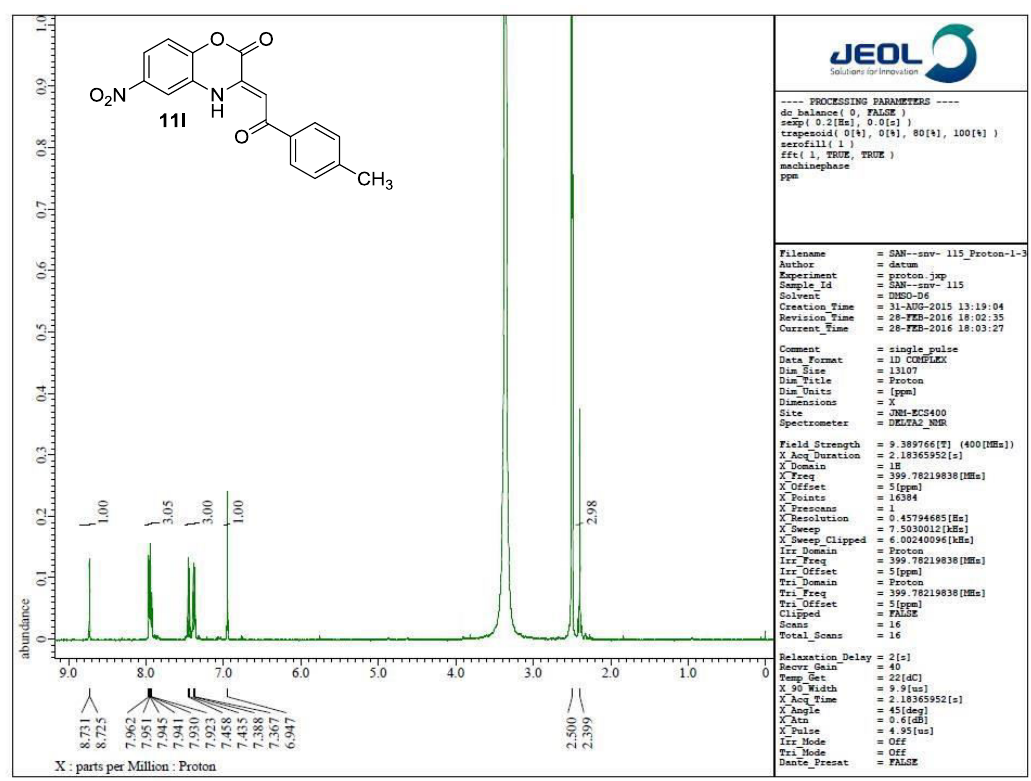
Figure 23. 1 H NMR Spectra of Compound 11l .